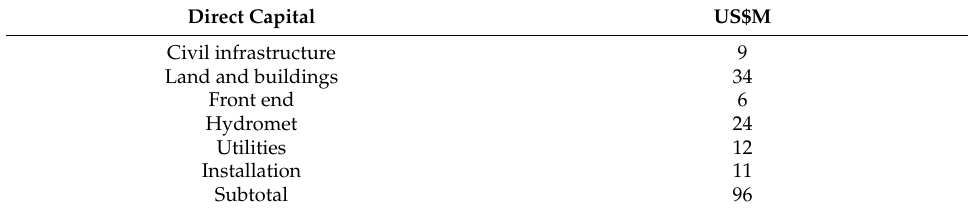
Table 4. CAPEX values (direct capital) of the company Neometals. Source: [35].